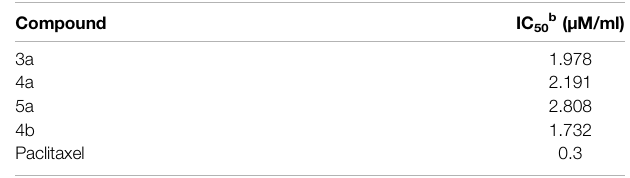
TABLE 4 | IC 50 values of synthesized compounds against K562 cell line. TABLE 3 | IC 50 values of synthesized compounds against A549 cell line.